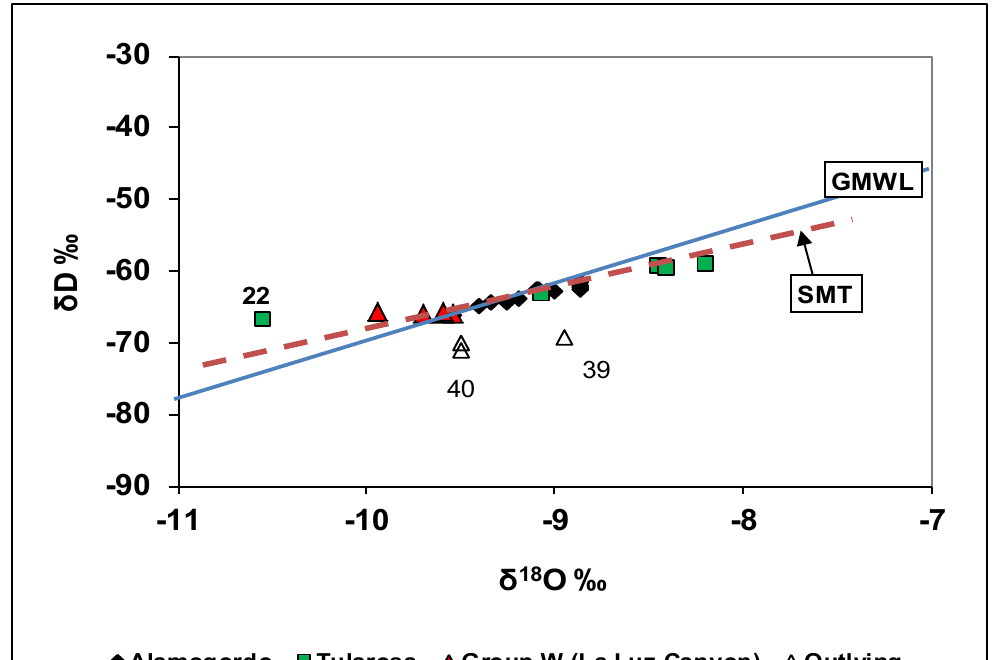
Figure 5. Plot of δ 18 O vs . δD for groundwater samples from basin sediments near Alamogordo and Tularosa, in relation to samples from La Luz and nearby canyons and the high Sacramento Mountains. Samples 1-39 and 1-40 are from basin fill more than 40 km south of Alamogordo (see Figures 1 and